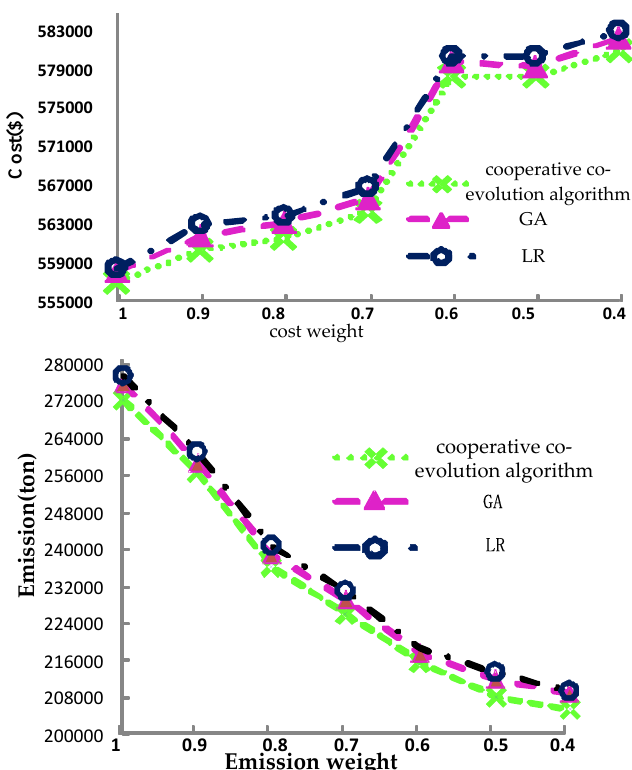
Figure 8. The comparison of cost and emission in different methods in Case 4.